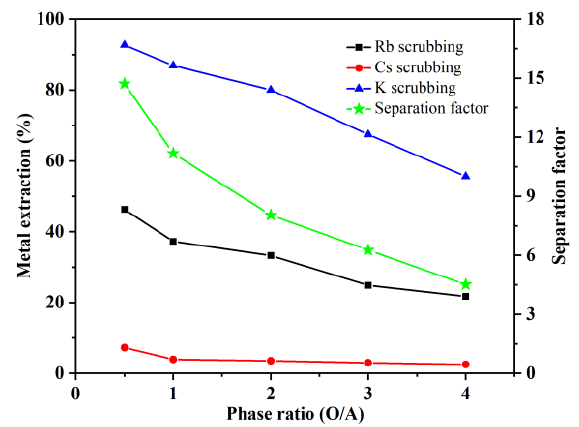
Figure 3. Effect of the O/A ratio on metal scrubbing by deionized water.